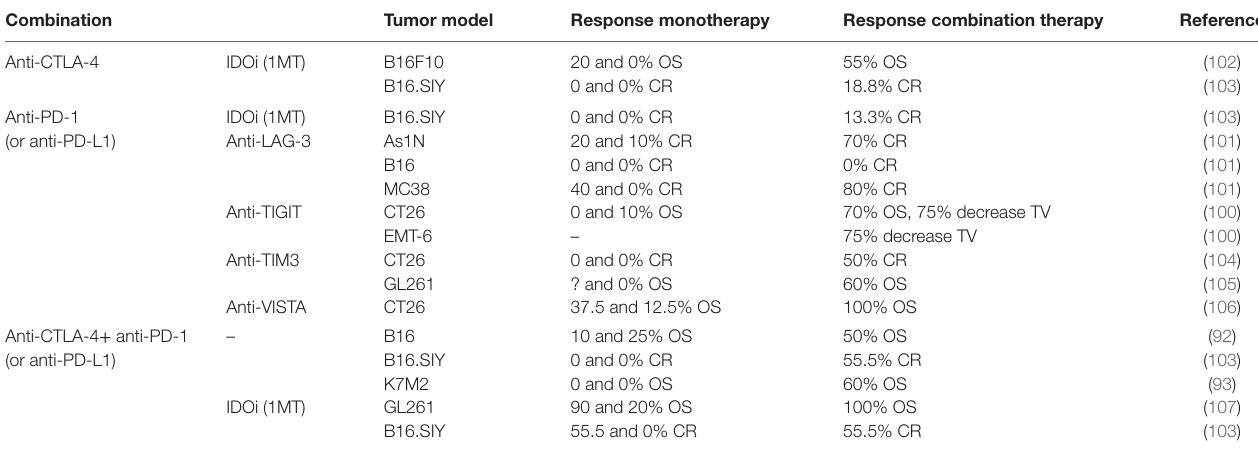
TABLe 1 | Preclinical studies double or triple immune-checkpoint